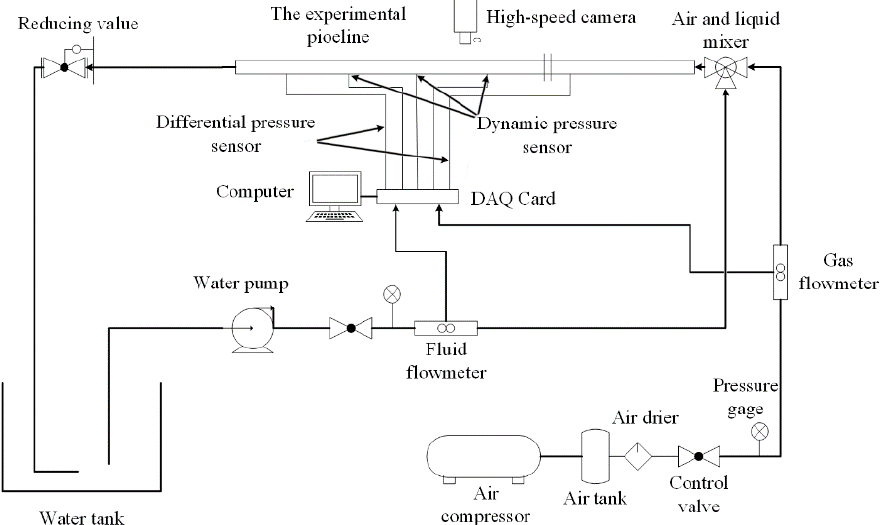
Figure 1. Schematic of experimental device.